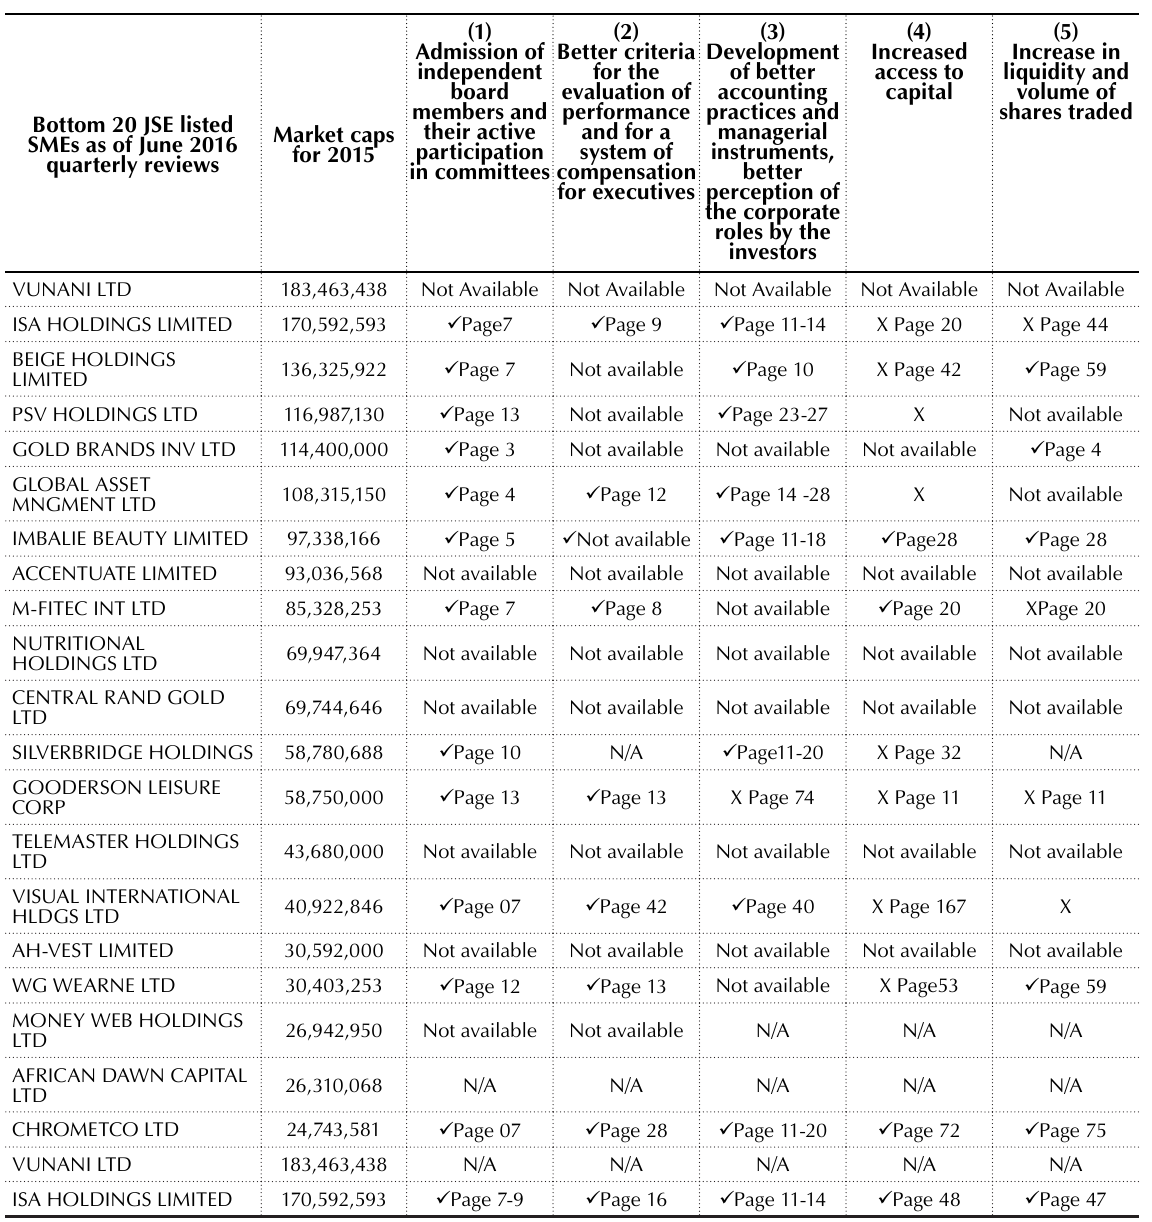
Table 2. Bottom 20 JSE Listed SMEs